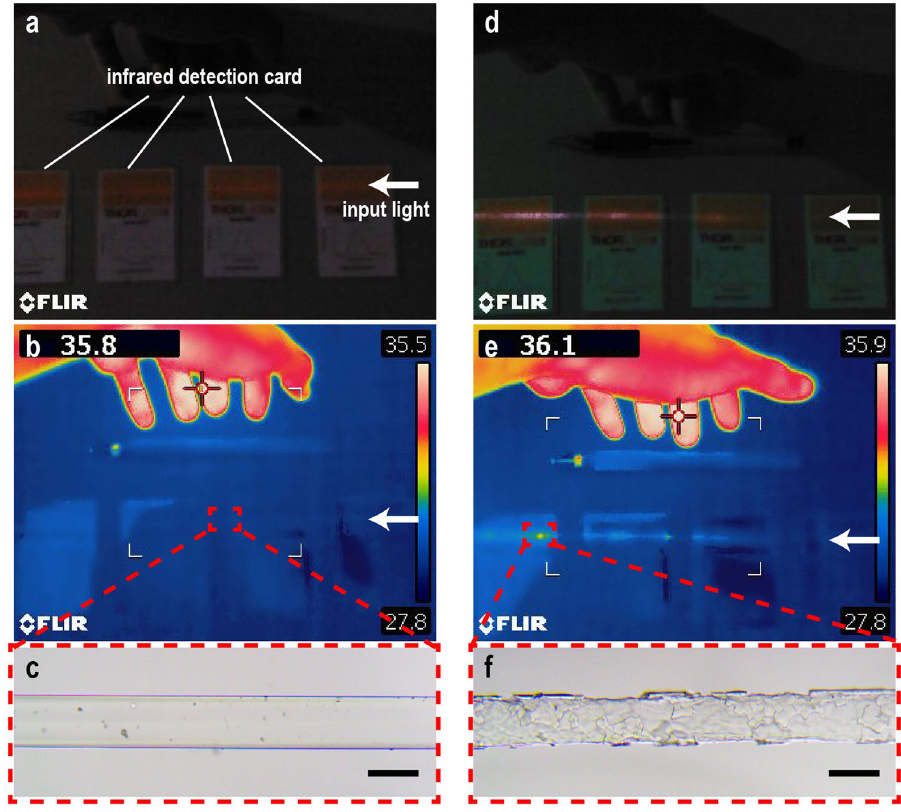
Figure 3. Fibers of which the output powers diminished in the heating process but without the IFF. ( a – c ) Are of the fiber of a loss of 1.94 W; ( d – f ) are of a loss of 5.78 W. ( a and d ) Photos of the respective fibers being input with their original input powers (8 W). The infrared detection cards uncover leaked laser light in both fibers. ( b and e ) Thermal images of the fibers. Human hands were included in the images to contrast with the temperature increases of the fibers. The numbers shown at the top-left of the images are the highest temperatures in the images in °C. ( c and f ) Micrographs of the fibers; bars are of 130- μ m